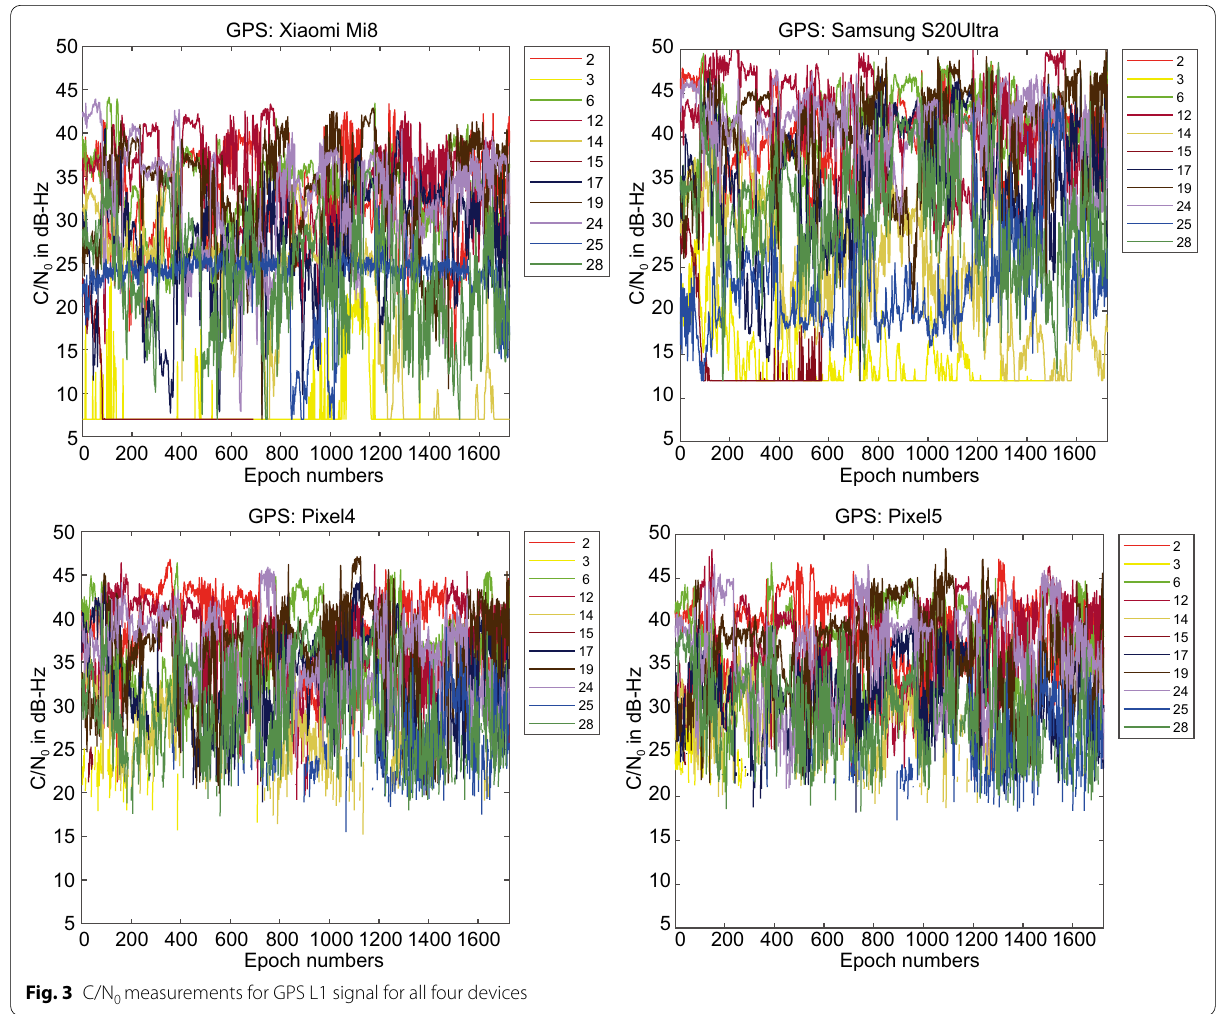
Fig. 3 C/N 0 measurements for GPS L1 signal for all four devices